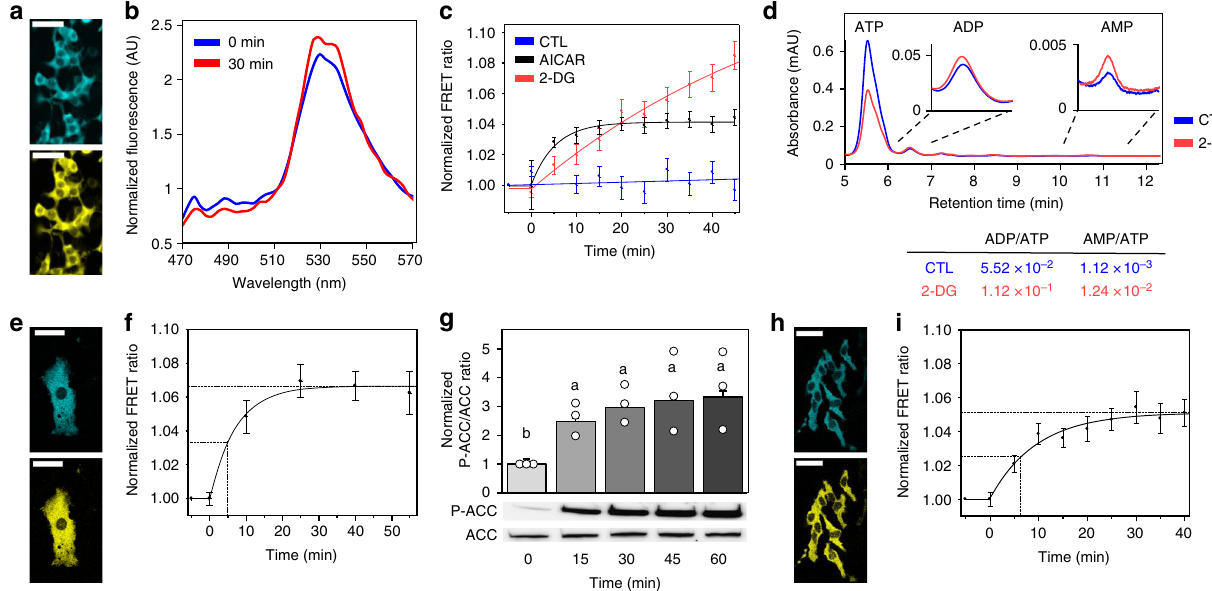
Fig. 5 AMPfret in cellulo. a – d HEK293T cells transfected with AMPfret 2.1. a Micrograph of CFP and YFP channels (scale bars: 50 µ m). b Fluorescence emission spectra before (0 min, blue) and after addition (30 min, red) of 1 mM AICAR, showing increase at 527 nm (cpVenus) and decrease at 478 nm (mseCFP Δ 11 ) over 30 min. c Normalized AMPfret FRET signal variation (YFP fl uorescence at 530 ± 5 nm/CFP fl uorescence at 478 ± 5 nm) after incubation with 1 mM AICAR (black), 20 mM 2-DG (red) or complete medium (control CTL, blue). Data of cell population normalized to values before treatment. Data and error bars represent mean ± SEM ( n = 64, n = 27, and n = 39 cells from at least two independent experiments for 2-DG, AICAR, and control, respectively). d HPLC quanti fi cation of adenylates in HEK293T cells treated for 50 min with complete medium (control CTL, blue) or 20 mM 2-DG medium (red). Curve (average of three-independent experiments) showing peaks with typical retention times of 5.5 min (ATP), 6.5 min (ADP) and 10.8 min (AMP), and adenylate ratios calculated thereof (same color code). e – g 3T3-L1 cells transfected with AMPfret 2.1. e Micrograph of CFP and YFP channels (scale bars: 50 µ m). f Normalized AMPfret FRET signal variation after incubation with 1 mM AICAR. Data of cell population normalized to values before AICAR addition. Data and error bars represent mean ± SEM ( n = 9 cells of two-independent experiments). g AICAR-dependent activation of AMPK veri fi ed